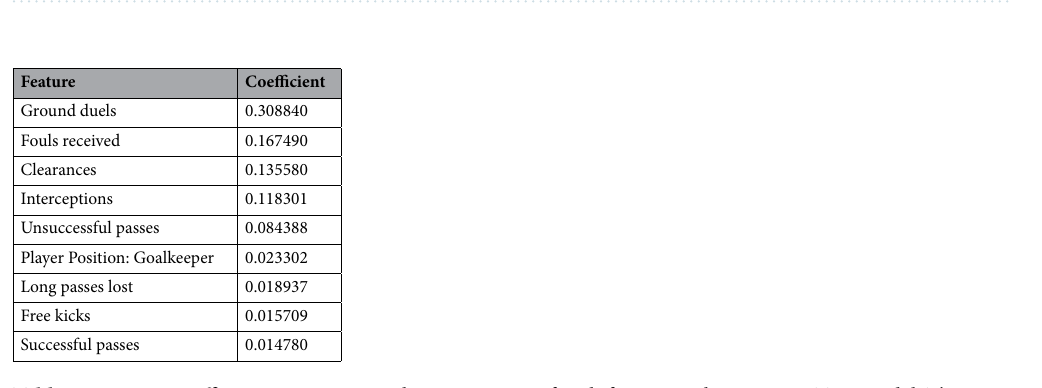
Table 7. Feature coefficients representing the importance of each feature in the Decision Tree model. The decision tree model assigns each feature importance depending on the information gain noted on the spit where the feature participates. The overall importance is scaled to